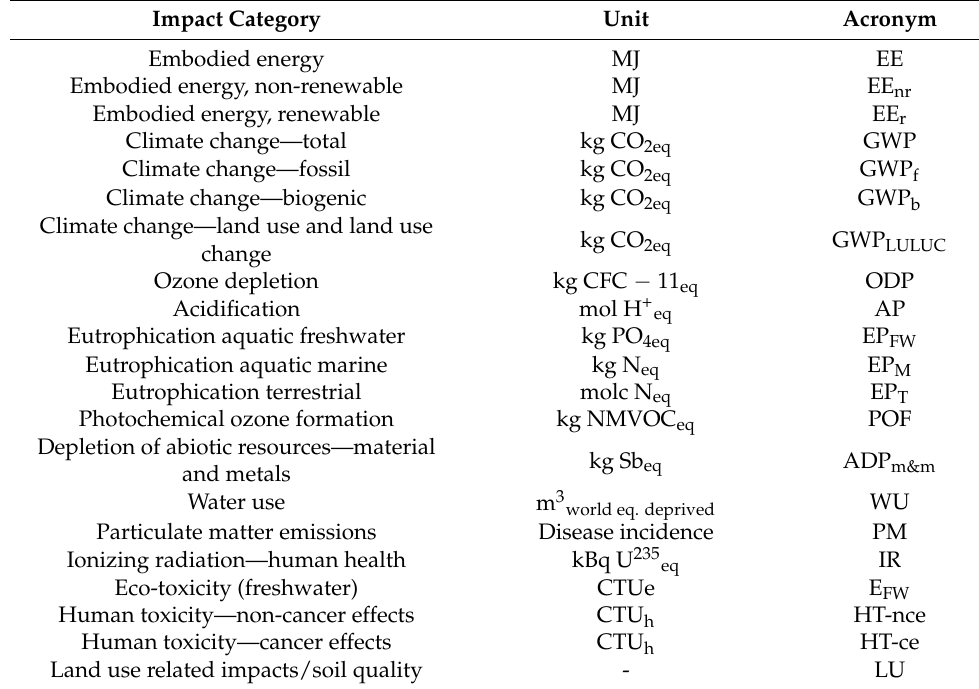
Table 1. Selected energy and environmental impact